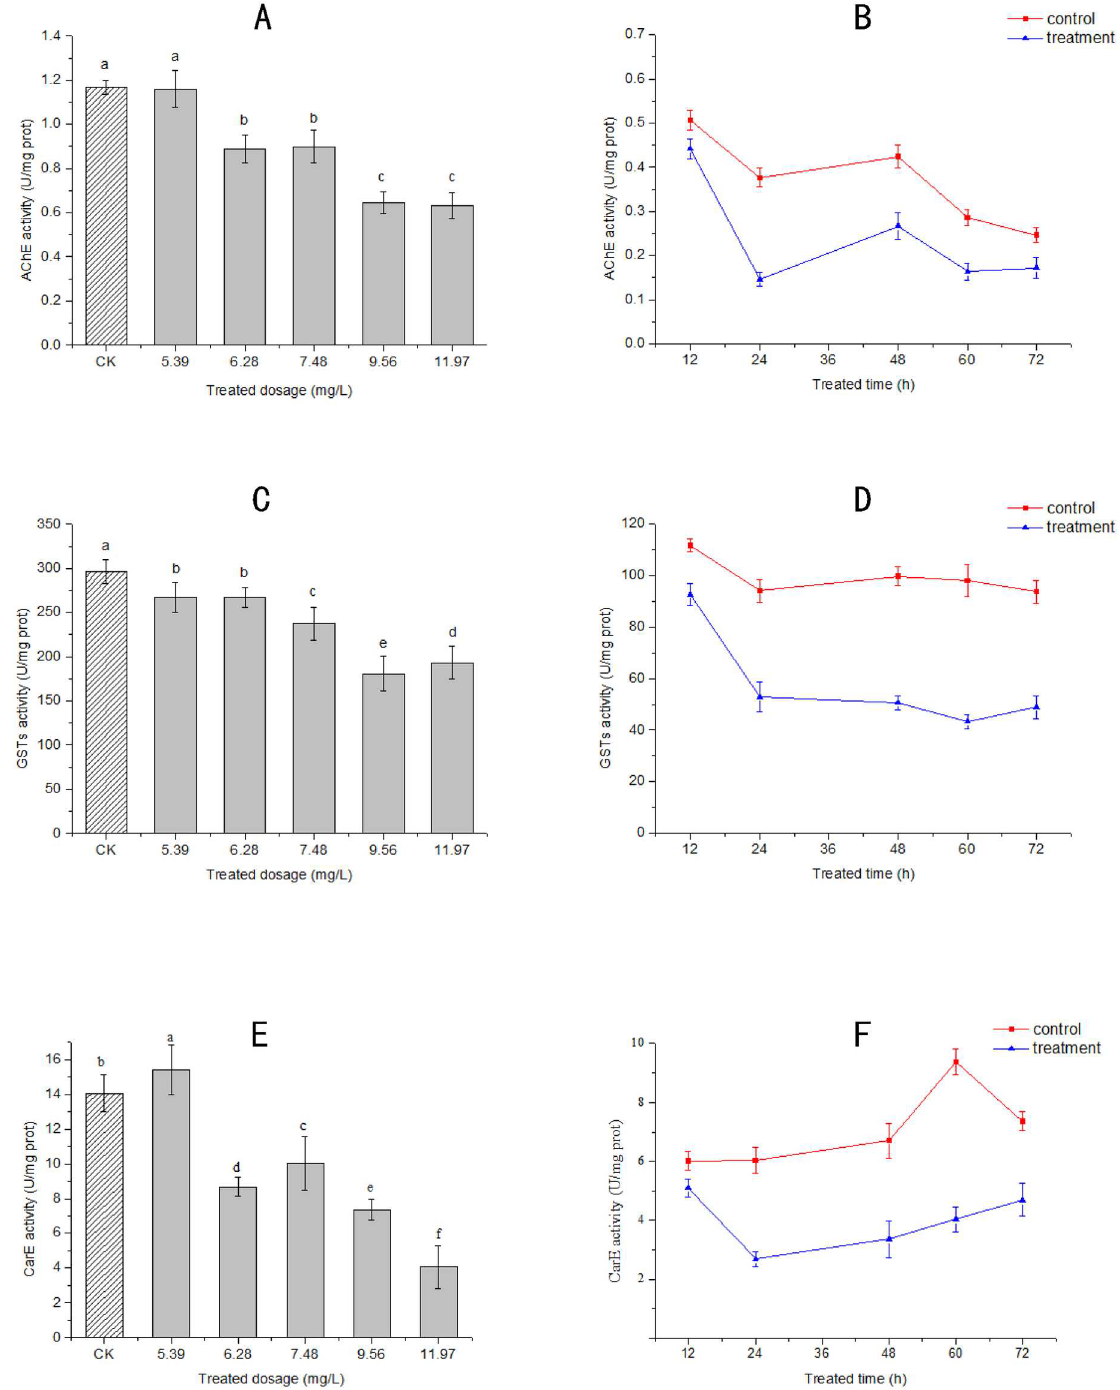
Fig 1. Effect of M . alternifolia essential oil fumigation at different concentrations on acetylcholinesterase (AChE) (A), glutathione S-transferase (GST) (C), and carboxylesterase(CarE) (E), and at different times with sub-lethal concentration (LC 50 ) of oil (6.78 mg/L at 24 h) on AChE (B), GST (D), and CarE (F) in adult S . zeamaisin vivo . CK represents the control groups. Results are reportedas mean ± SE (calculated from three independent experiments). Different minor case letters at the top of the columns mean significantdifferences of essentialoil at a p value of 0.05.